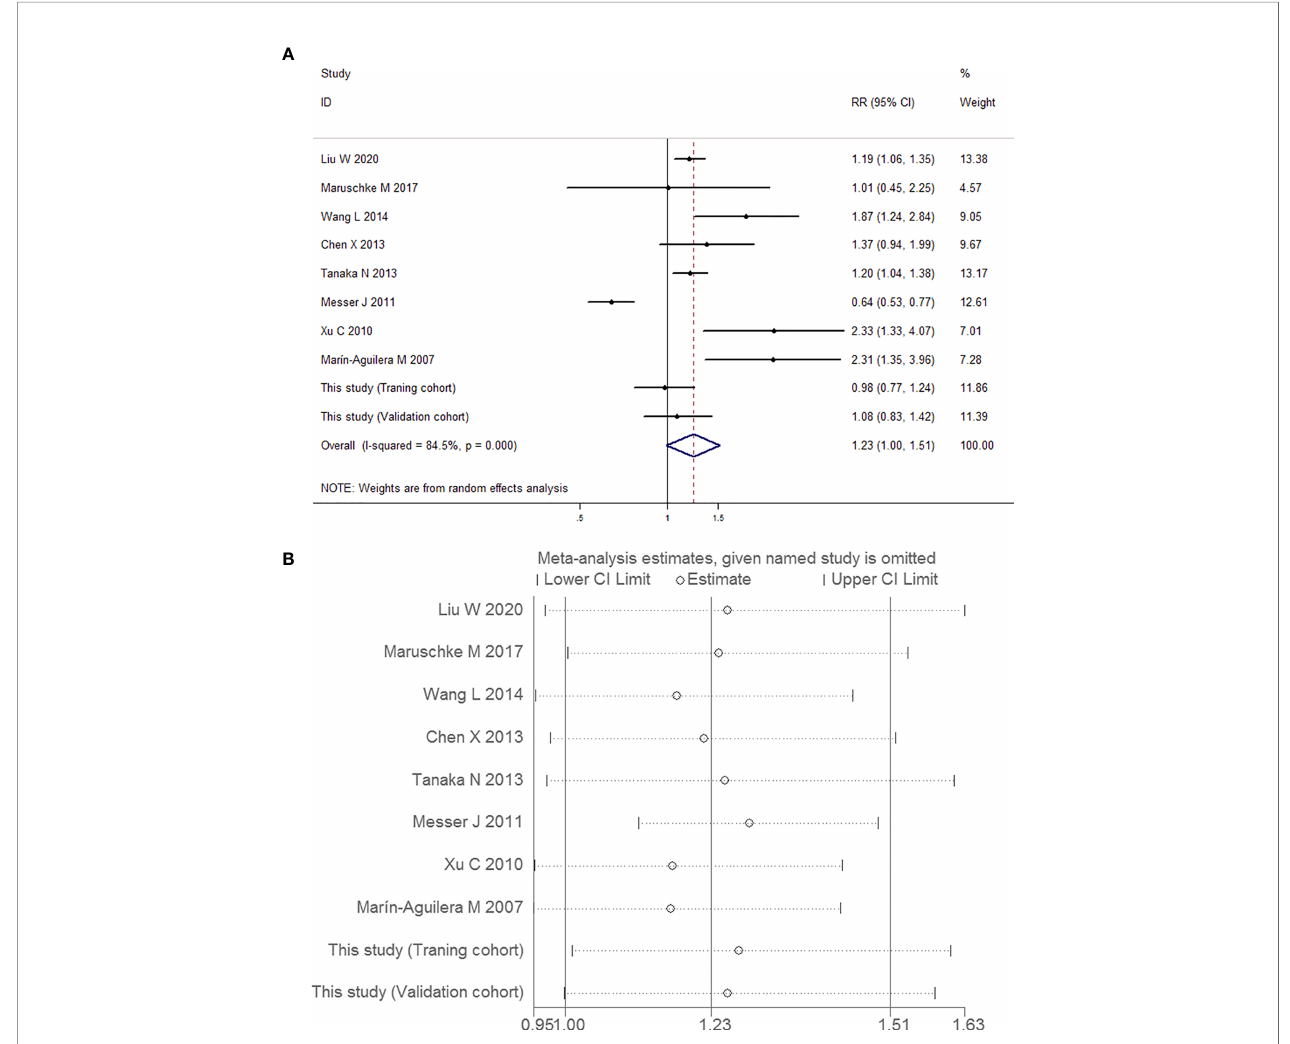
FIGURE 12 | Forest plots for the risk of high-grade UUT-UC in patients with preoperative positive urine cytology. (A) Meta-analysis. (B) Sensitivity